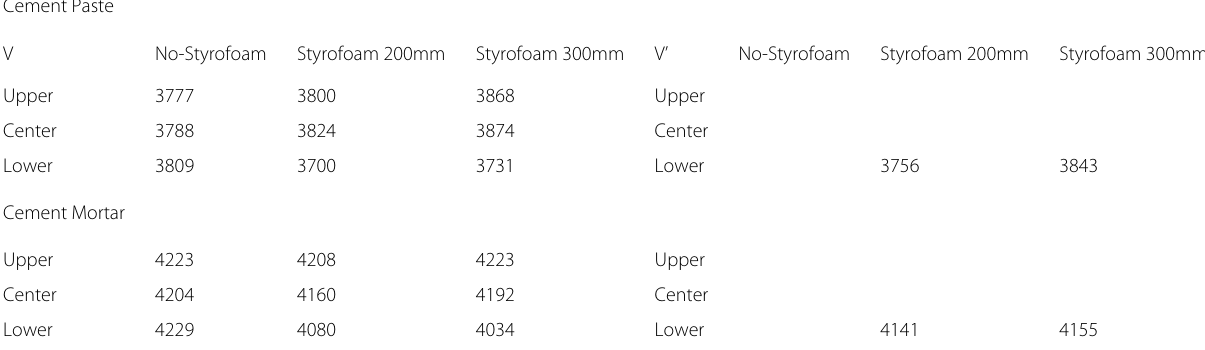
Table 2 Tables of modification of the velocity (age of 4 weeks) Cement